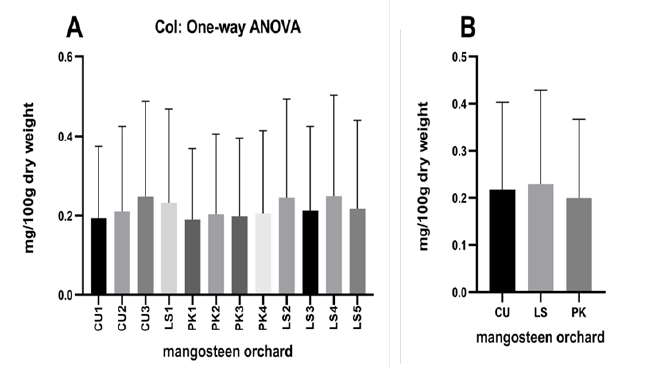
Figure 6: The amount of alpha-mangostin in mangosteen pericarp extract. (A) bar graph represents the mean amount of alpha-mangostin of 12 orchards. (B) bar graph represents the mean amount of alpha- mangostin of the orchards from the three